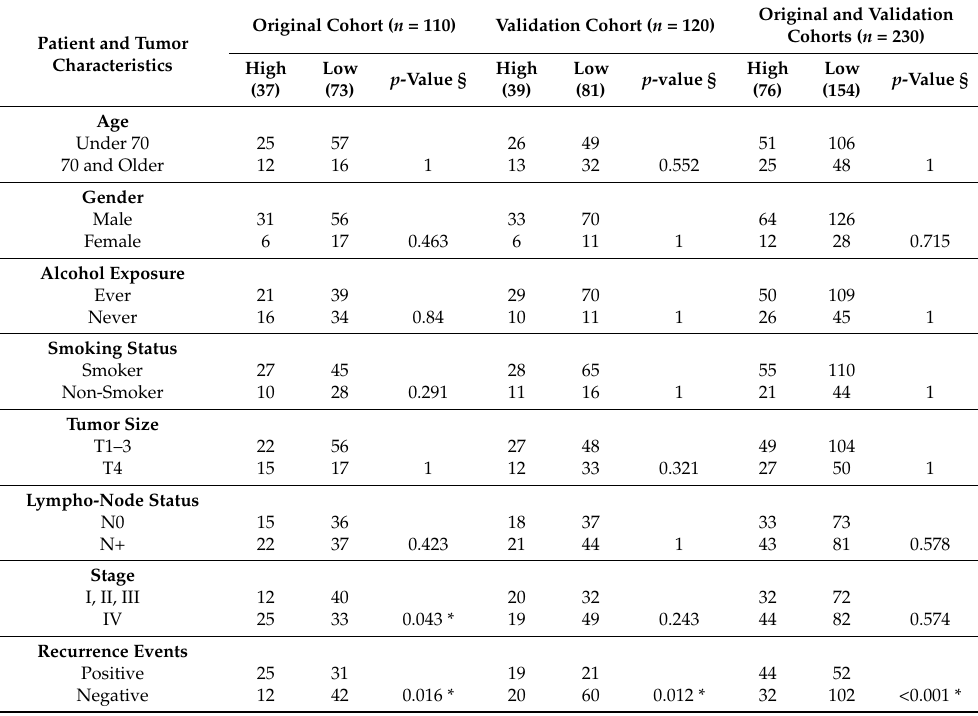
Table 1. EZH2 gene expression status in (head and neck squamous cell cancer) HNSCC primary samples.